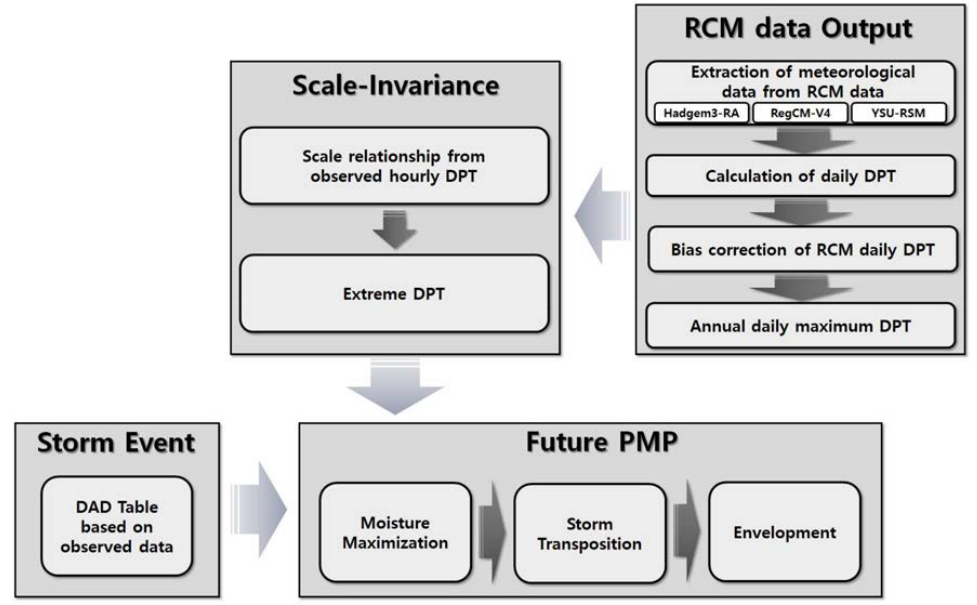
Figure 2. Procedure for future PMPs using the hydro-meteorological method with future meteorological data produced from